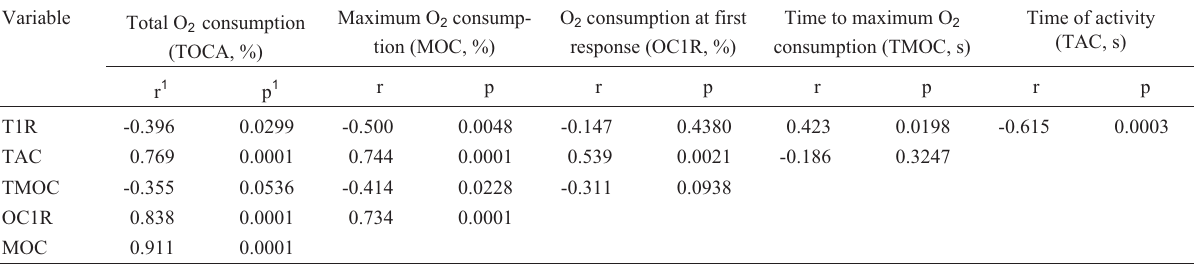
Table III - Correlation between the variables studied